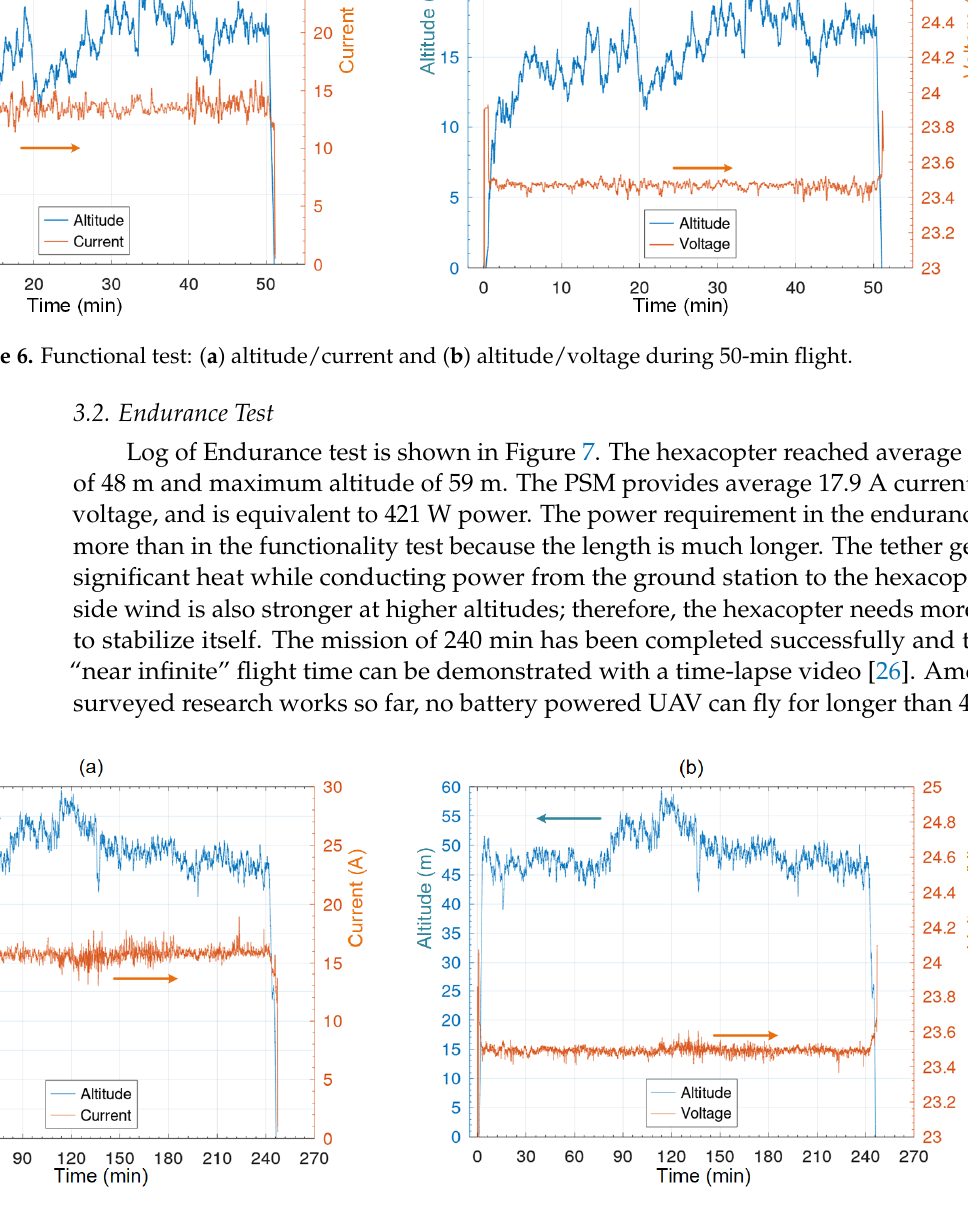
Figure 7. Endurance test: ( a ) altitude/current and ( b ) altitude/voltage during 240-min flight. Averaged measurement data during the endurance test are listed in Table 5 along with those derived from the model in the previous section. In the endurance test, total tether length in air is 60 m and data are derived based on this length. Table 5. Endurance test data and data from model. Item